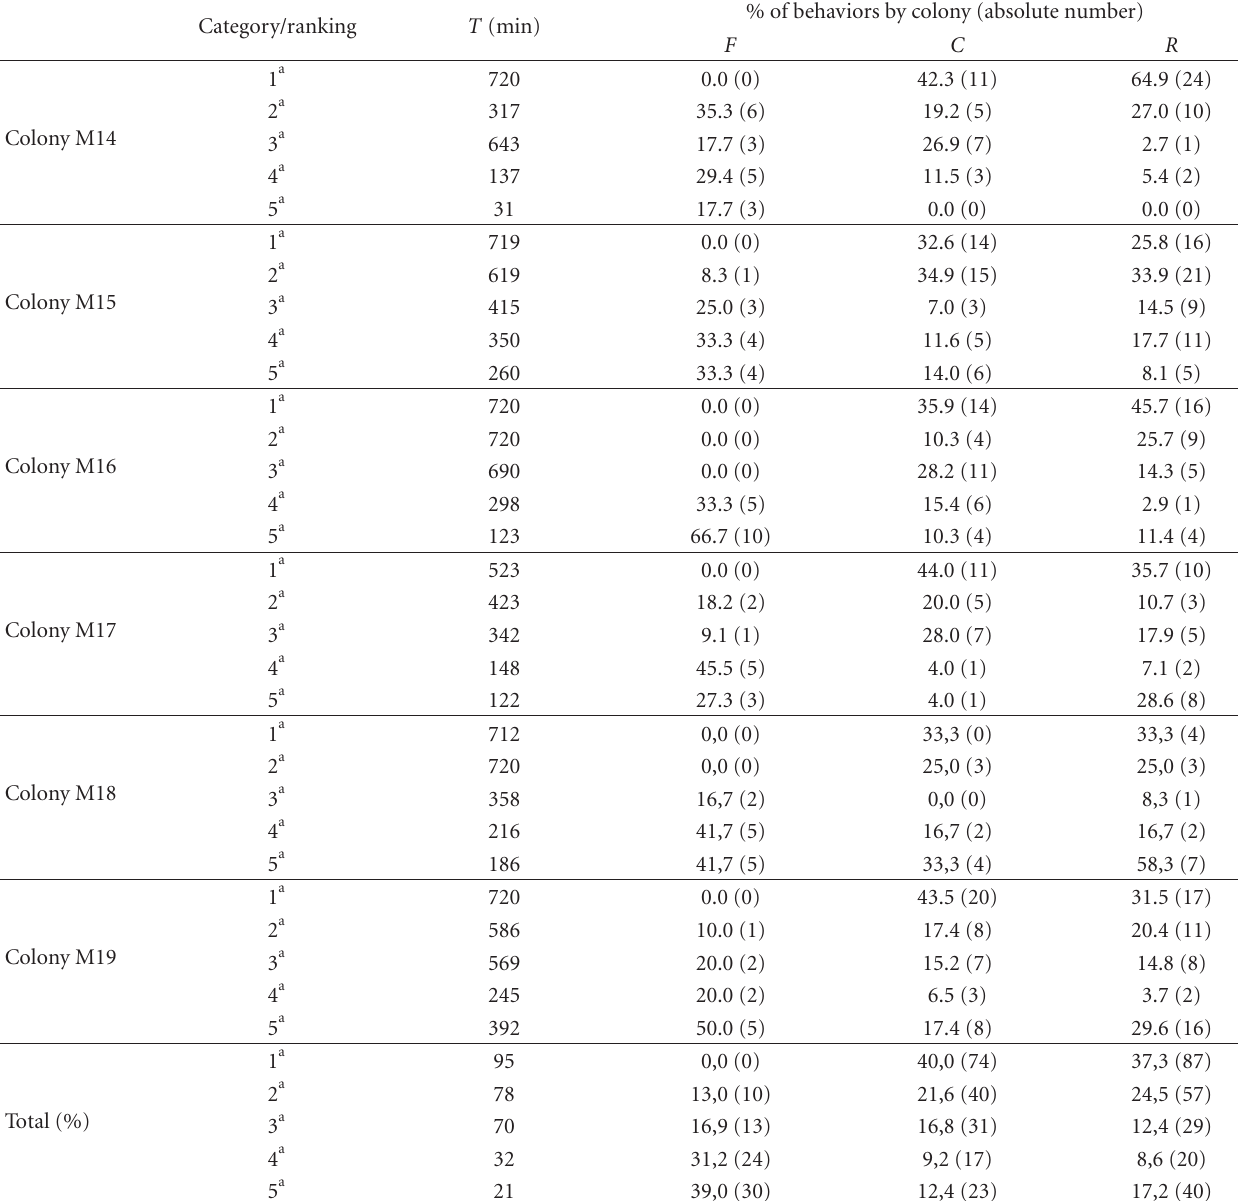
Table 3: Time in the nest ( T ) of foraging activities ( F ), cell inspection ( C ), and gaster rubbing ( R ) of all individuals by colony during the determination of dominance hierarchy.